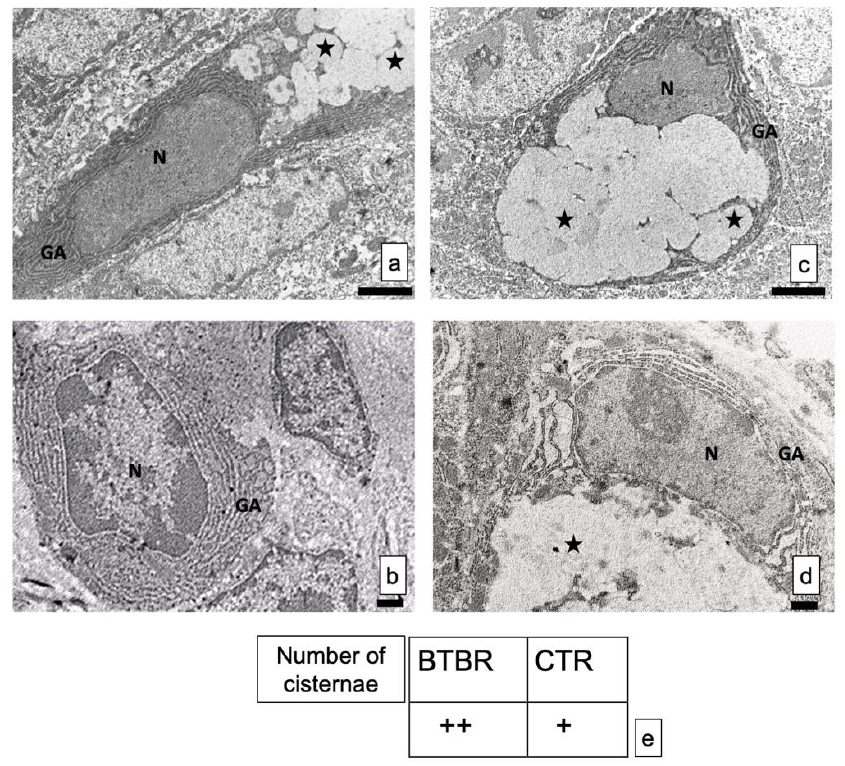
Figure 5. ( a – d ) Representative ultrastructural images of intestinal goblet cells in BTBR and CTR mice. ( a , b ) BTBR mice; ( c , d ) CTR animals. Vesicles of goblet cells are indicated as black stars; nucleus of goblet cells is indicated as N; Golgi’s apparatus is indicated as GA. Bar: ( a , b )—2 μm; ( c , d )—1 μm. ( a – c )—6200×; ( b , d )—8700×; ( e ) semiquantitative evaluation of cisternae in Golgi apparatus of BTBR and CTR animals. The number of animals was 10 for BTBR and 10 for CTR; moreover, three samples for each animal were used. The images are a representative sample of all the tissues examined. (+): from 4 to 8 cisternae and (++): several cisternae higher than 8.